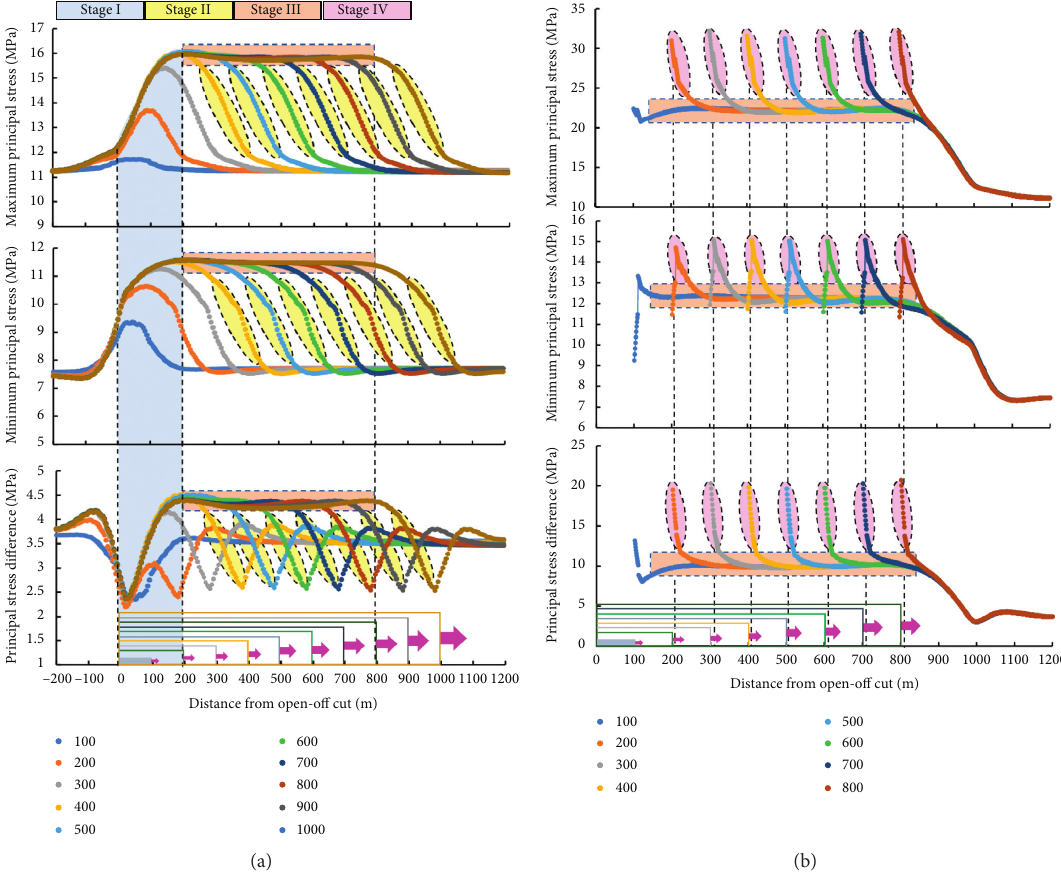
Figure 7: Distribution characteristics of repeated mining stress stages. (a) The primary mining. (b) The second